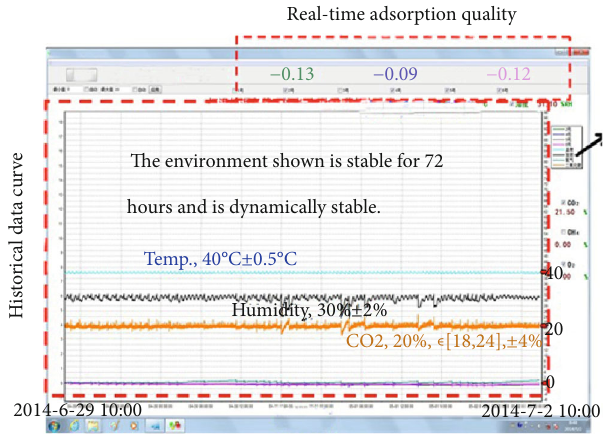
Figure 11: Computer terminal software interface.